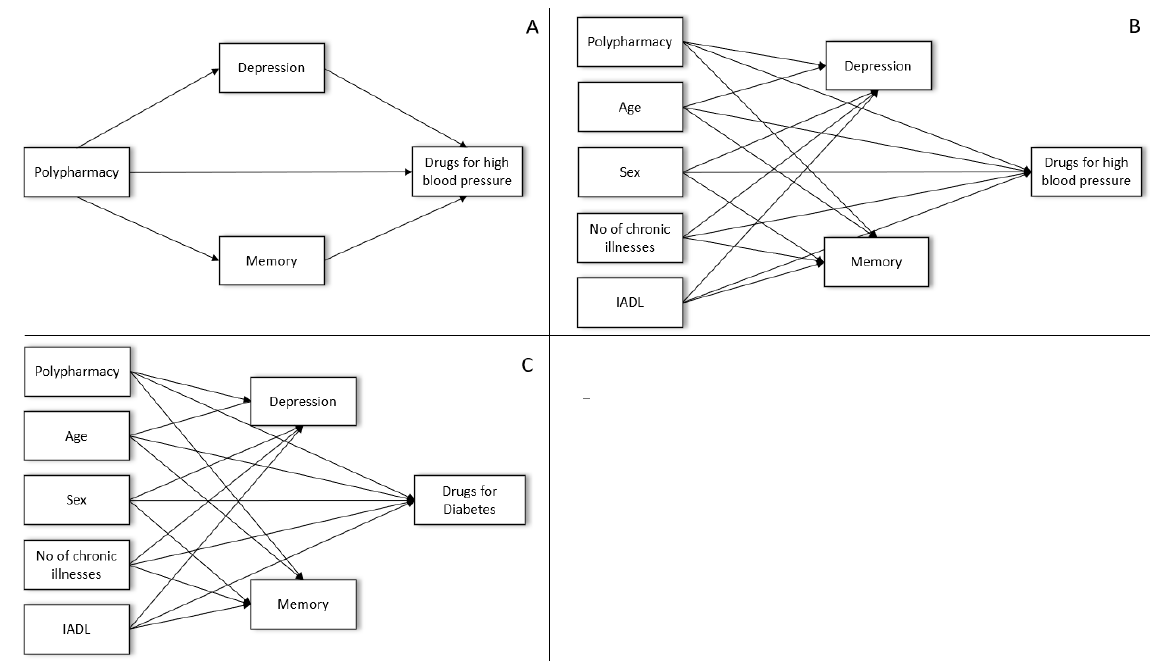
Figure 4. Mediation models. ( A ) Simple mediation model for hypertension, including only depression and memory. ( B ) A comprehensive mediation model for hypertension. ( C ) . Comprehensive mediation model for diabetes. Note: IADL = instrumental activities of daily living.